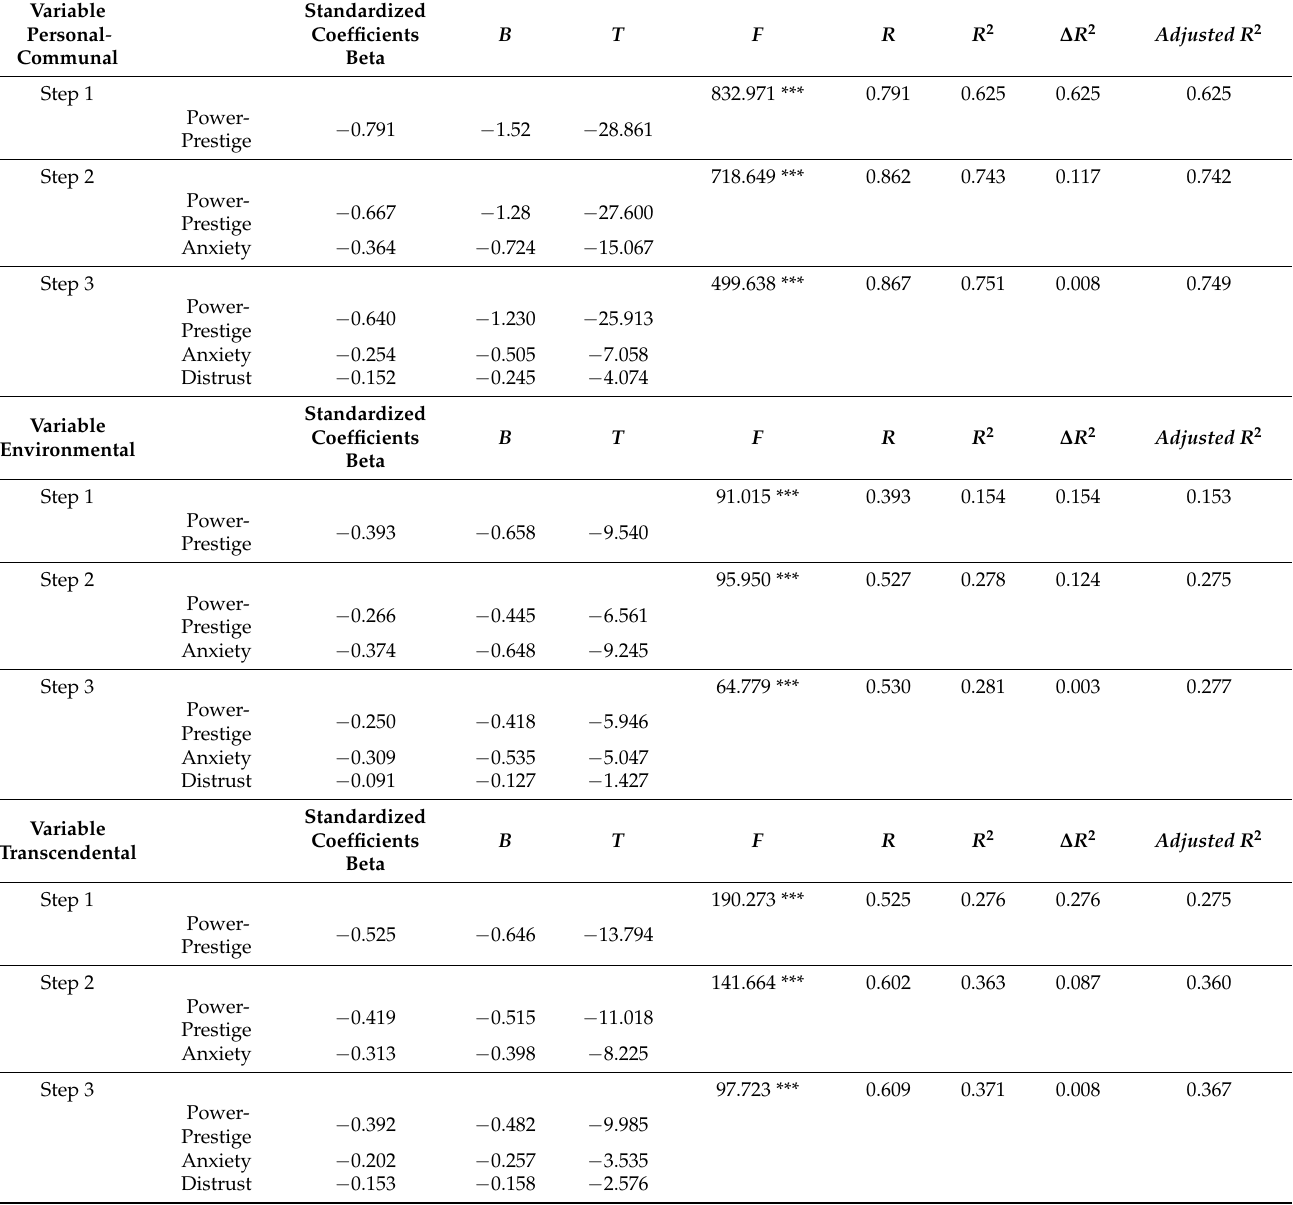
Table 6. Results of Stepwise Multiple Regression Analyses with money attitude in the dimensions of power and prestige, anxiety and distrust as Predictors of the participants’ spiritual well-being in the personal-communal, environmental and transcendental